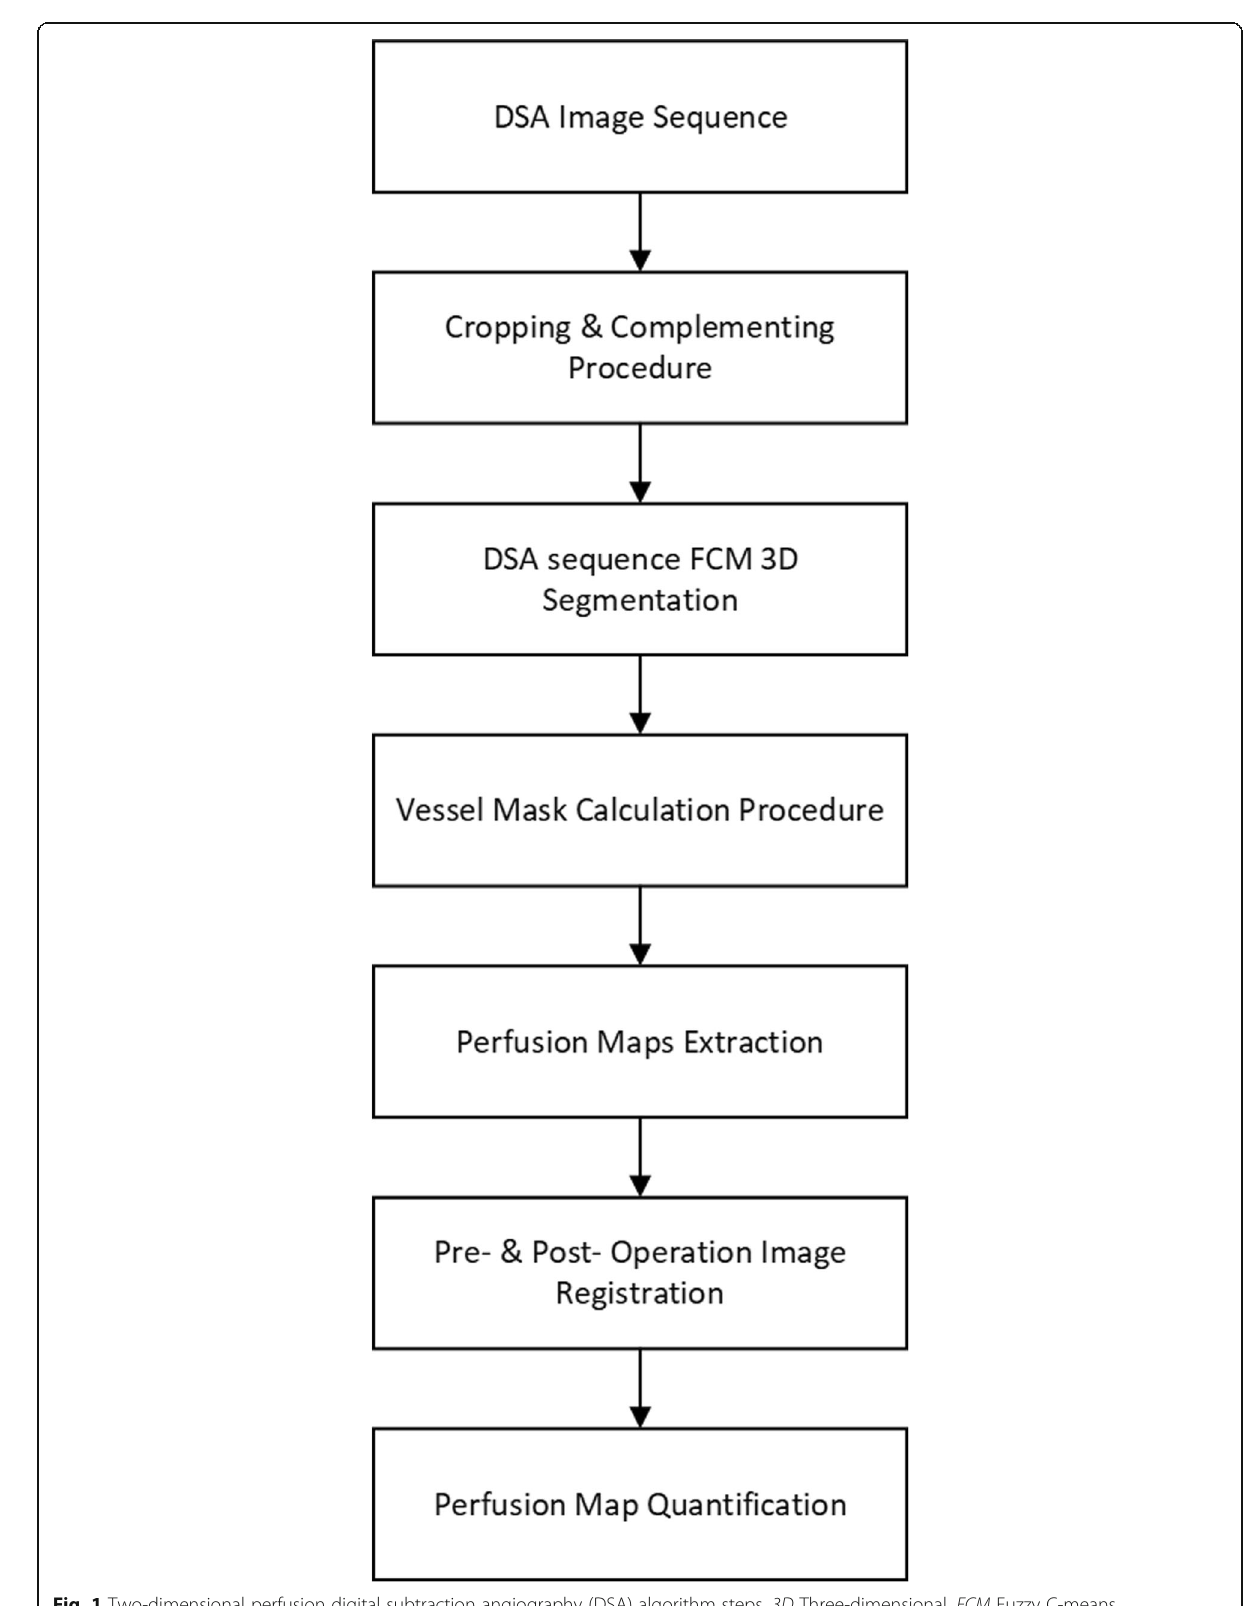
Fig. 1 Two-dimensional perfusion digital subtraction angiography (DSA) algorithm steps. 3D Three-dimensional, FCM Fuzzy